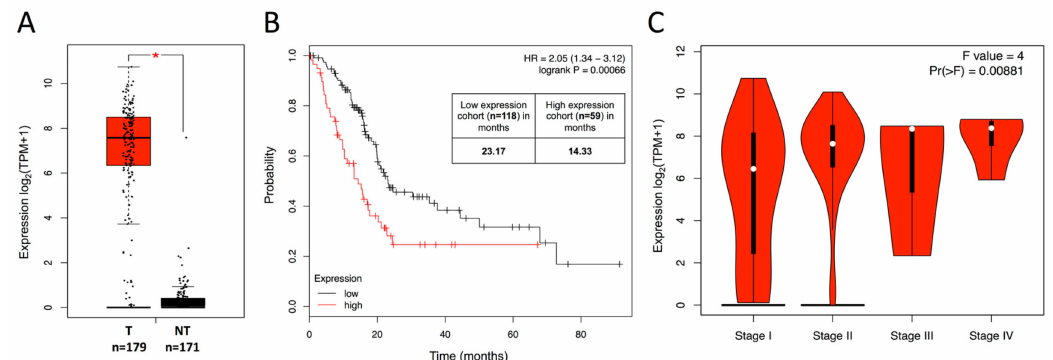
Figure 1. Prognostic value of mesothelin expression by pancreatic ductal adenocarcinoma (PDAC) patients for survival. ( A ) Expression of mesothelin in tumoral (T) and nontumoral (NT) pancreatic tissues from The Cancer Genomic Atlas (TCGA) and Genomic Tissue-Expression (GTEx) datasets. The red and gray boxes represent PDAC and nontumoral-derived tissues, respectively (T: n = 179 and NT: n = 171). ( B ) Kaplan–Meier plots of overall survival probability (plotted on Y-axis) of PDAC cancer patients is shown (TCGA data, n = 177). Patients have been stratified into high (red lines, n = 59) or low (black lines, n = 118) expression-based “risk-groups” by their gene expression of mesothelin. The patient follow-up is indicated in months on the X-axis. Respective log-rank test p -value, HR, and computed median survivals of low and high expression cohorts in months are shown and were calculated at the best auto-selected cut-o ff . ( C ) Violin plot showing the average gene expression levels of mesothelin at early (I and II) and advanced (III and IV) cancer stages of PDAC patients (TCGA database, n = 179). * p <